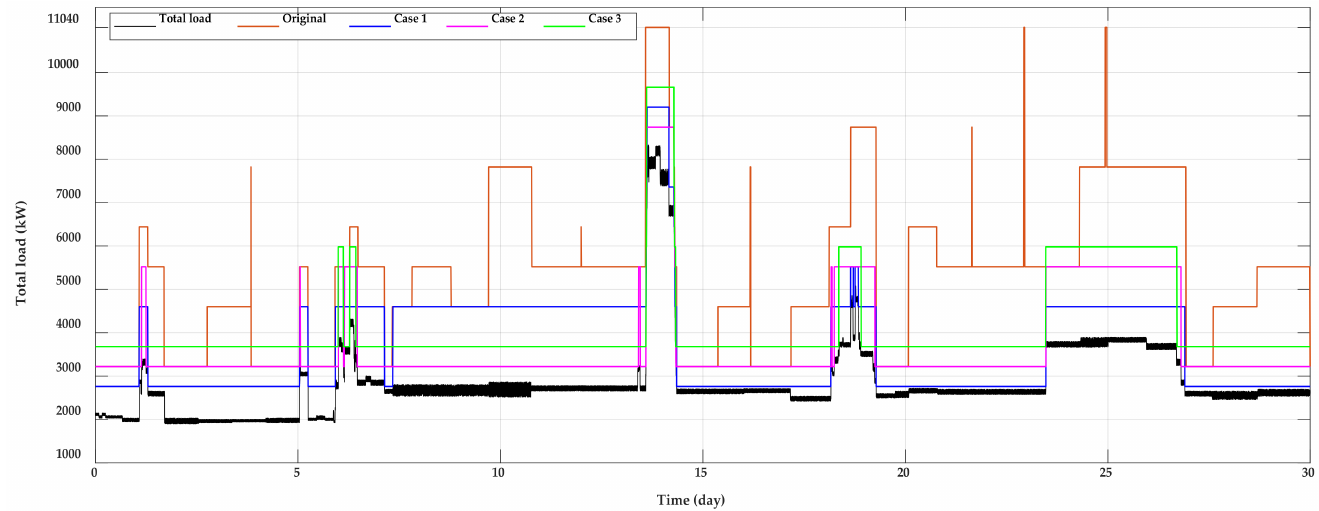
Figure 9. Spinning reserve power of all cases and original